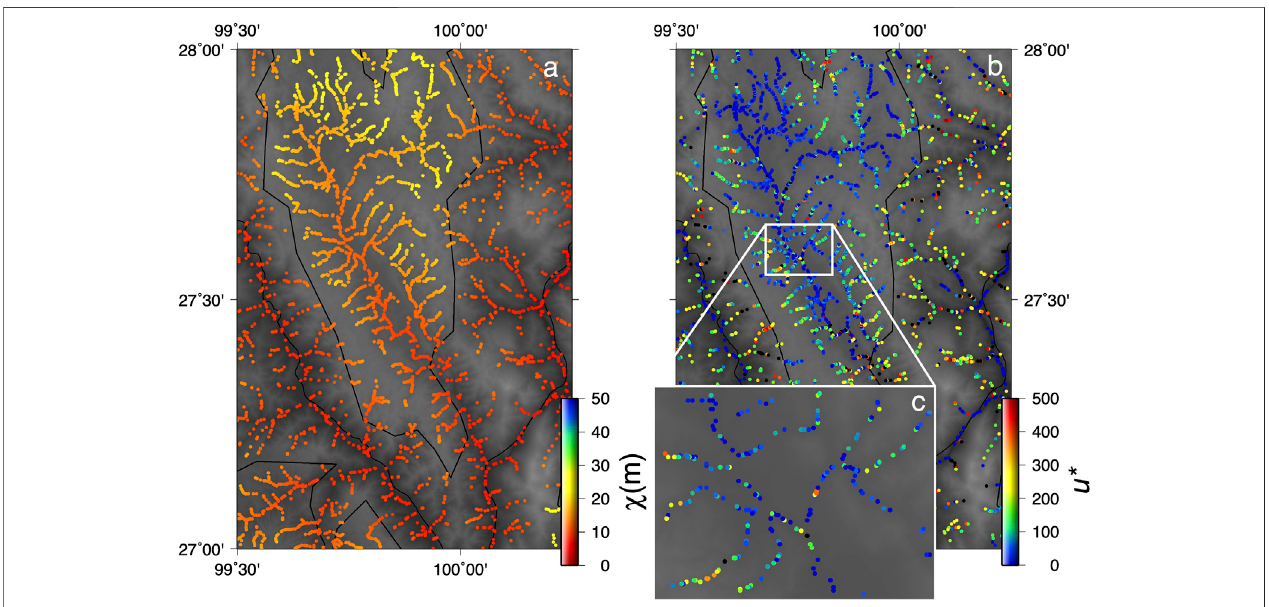
FIGURE 4 | 4Subsampling the data. (A) The complete dataset was trimmed by randomly removing 90% of the pixels outside of the low-relief surfaces and 75% withinthelow-relief surfaces. (B) Localnormalizedchannel steepness maps valueshighlightregionalpatterns but areverynoisyand thus mustbe fi lteredoraveragedto make interpretations. (C) Zoomed in portion showing data distribution and variability in the normalized steepness data.